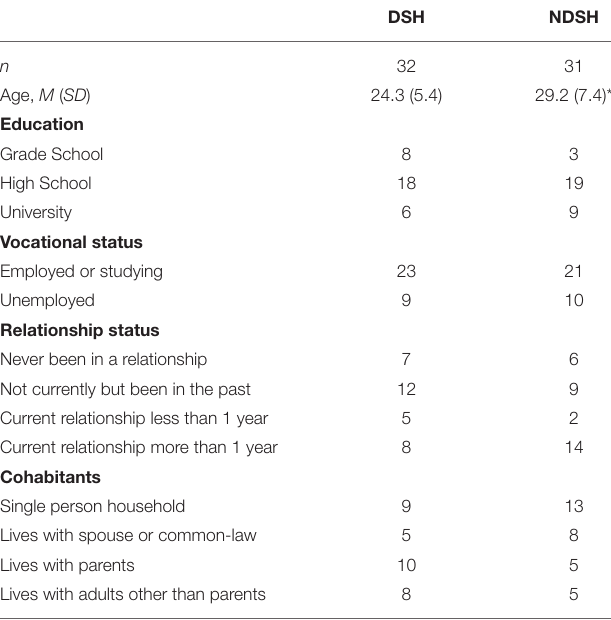
TABLE 1 | Demographic characteristics for the two study